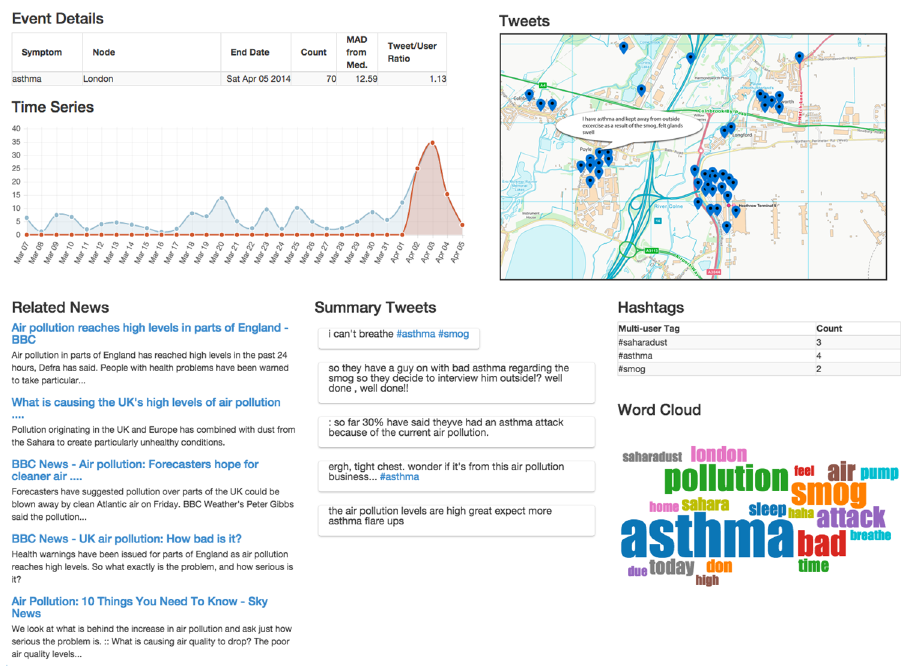
Fig 4. DEFENDER Situational Awareness screen showing asthma event in London from April 2014. Moving counter-clockwise from the top left the screen shows: 1. Event Details: Basic information about the timing and severity of the event. 2. Time Series: A graph showing the symptom counts for the previous 30 days with the alarm period highlighted in red. 3. Related News: Most relevant news articles selected by TNT algorithm. 4. Summary Tweets: Most relevant tweets selected by TNT. 5. Word Cloud: Visual representation of words used most frequently in the tweets. 6. Hashtags: Tags used by multiple users within the event. 7. Tweets: Map showing locations of individual tweets. The map shown here is for illustrative purposes only due to copyright. Contains OS data, Crown copyright [and database right] (2016).